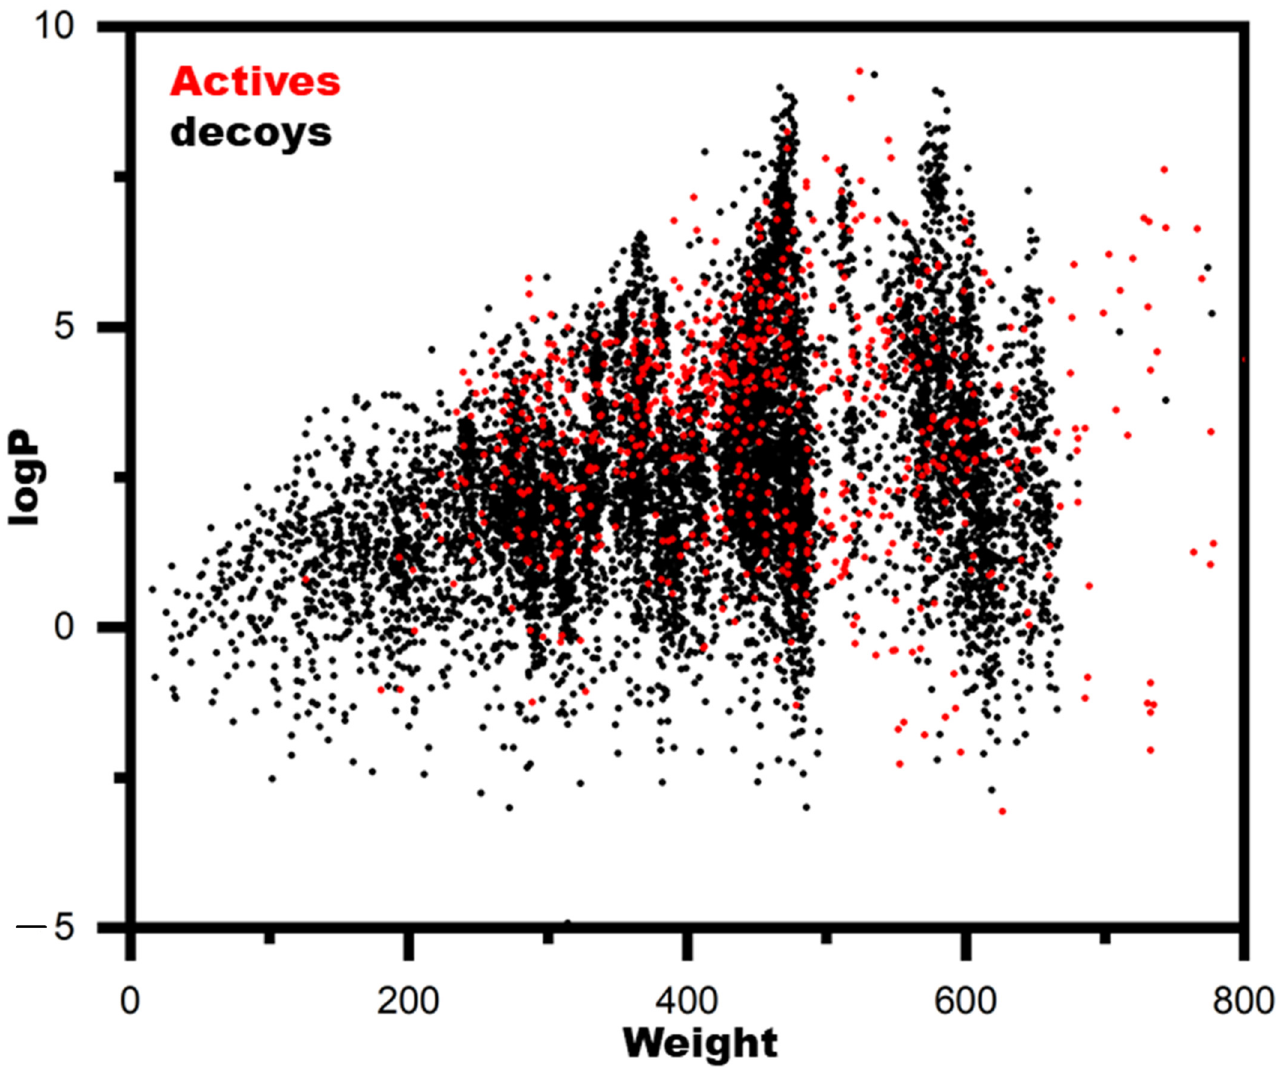
Figure 3. Chemical space analysis of the actives and decoys. The chemical space was defined as the weight and logP.